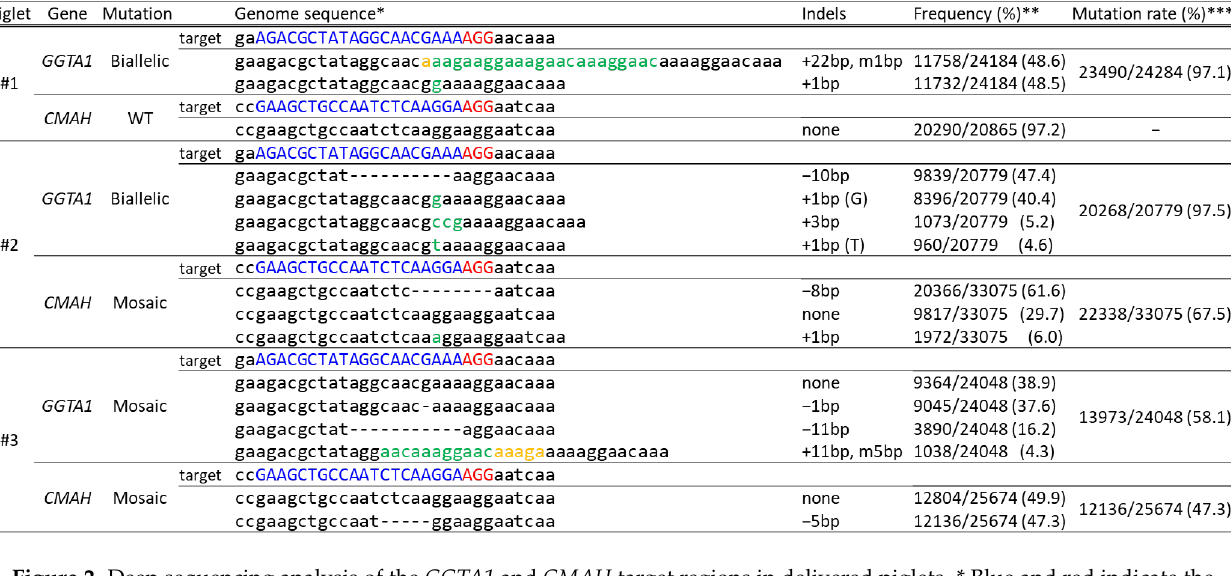
Figure 2. Deep sequencing analysis of the GGTA1 and CMAH target regions in delivered piglets. * Blue and red indicate the target sequences and protospacer adjacent motif (PAM) sequences of each gRNA, respectively. Green and yellow represent inserted and modified sequences, respectively. ** The frequency was defined as the ratio of the number of amplicons to the total read number. *** The mutation rate was defined as the ratio of the total number of mutant amplicons to the total read number. WT, wild-type.